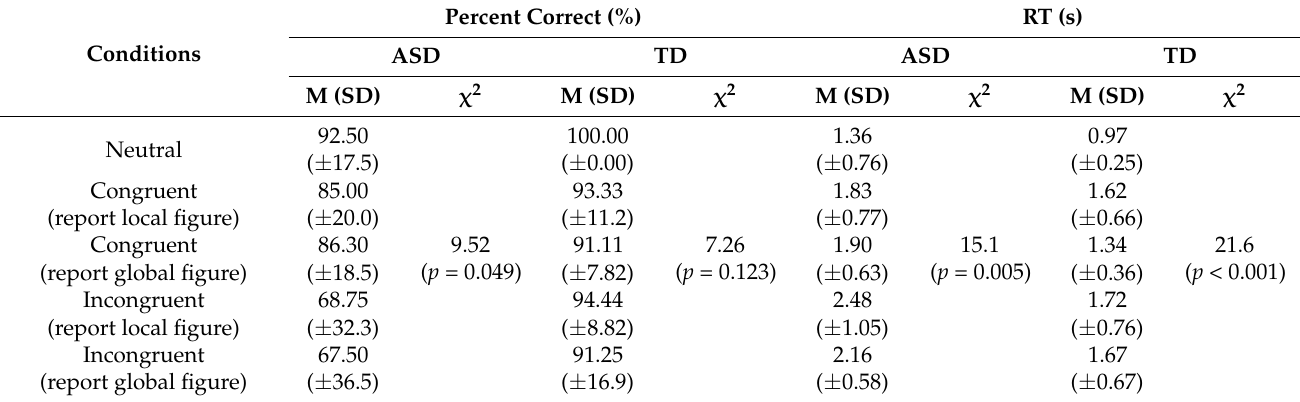
Table 2. Descriptive statistics of percent correct and response